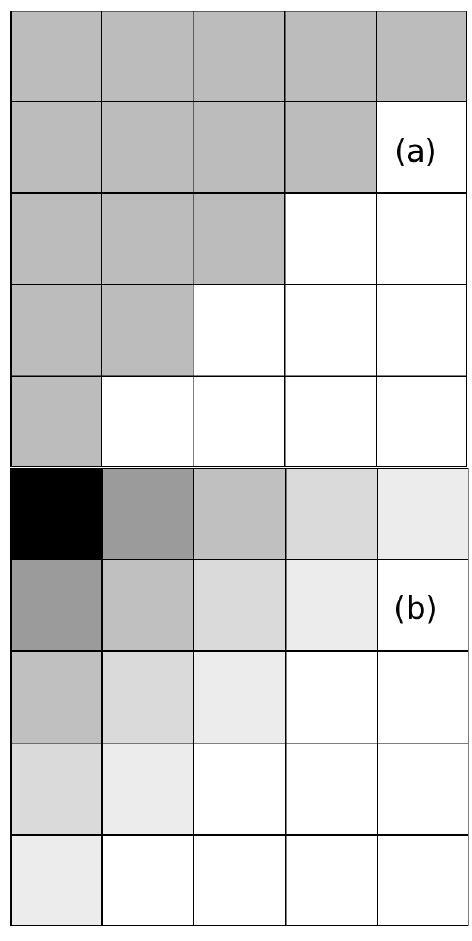
Fig. 2: The maximal nestedness pattern exemplified for qualitative (a) and quantitative (b) cases. In the second situation the weight of the link between species is indicated by grey